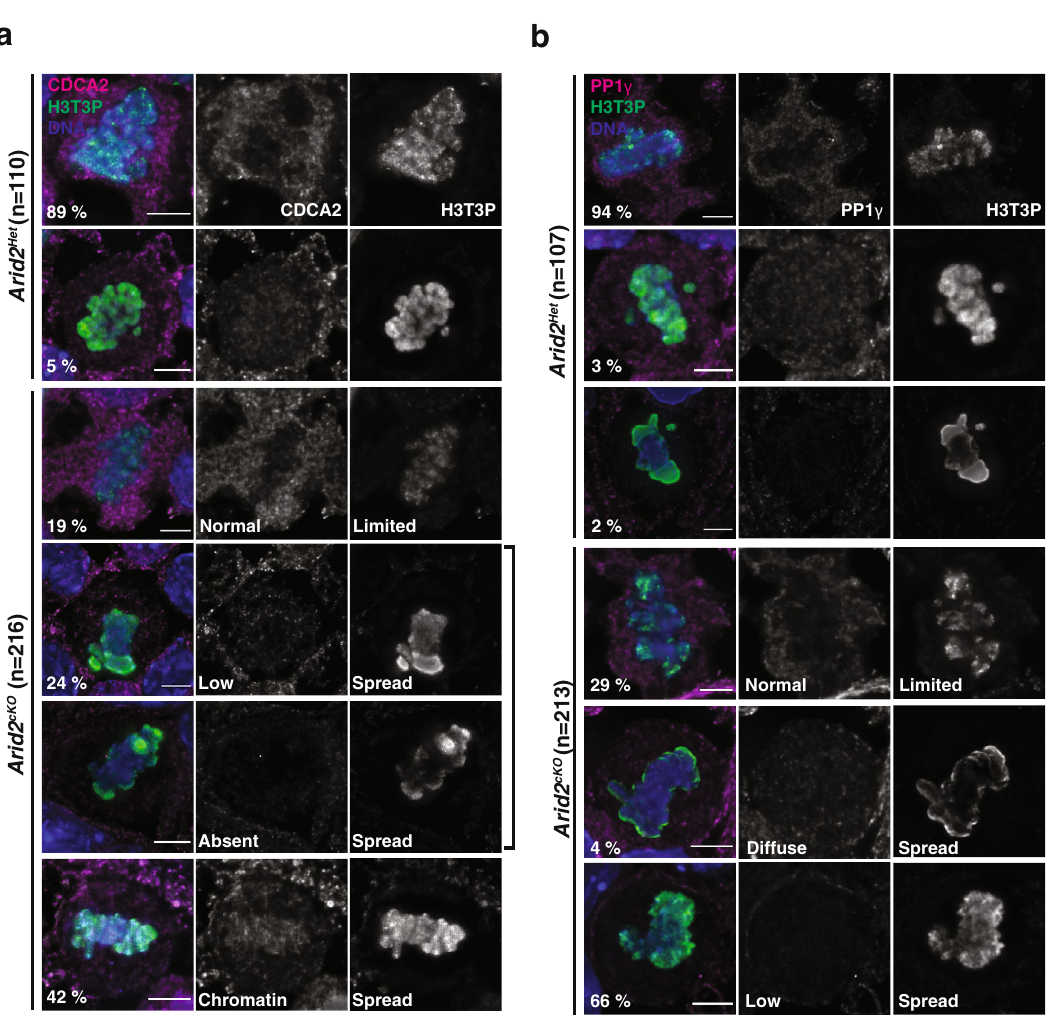
Fig. 7 CDCA2-PP1 γ abundance is regulated by ARID2. Arid2 Het and Arid2 cKO metaphase-I spermatocytes immunolabelled for H3T3P (green) and a CDCA2 (magenta), b PP1 γ (magenta). a , b DNA counterstained with DAPI (blue). Scale bars: 5 μ m, magni fi cation: 100.8x. Number ( n ) of metaphase-I spermatocytes scored and proportions (%) are